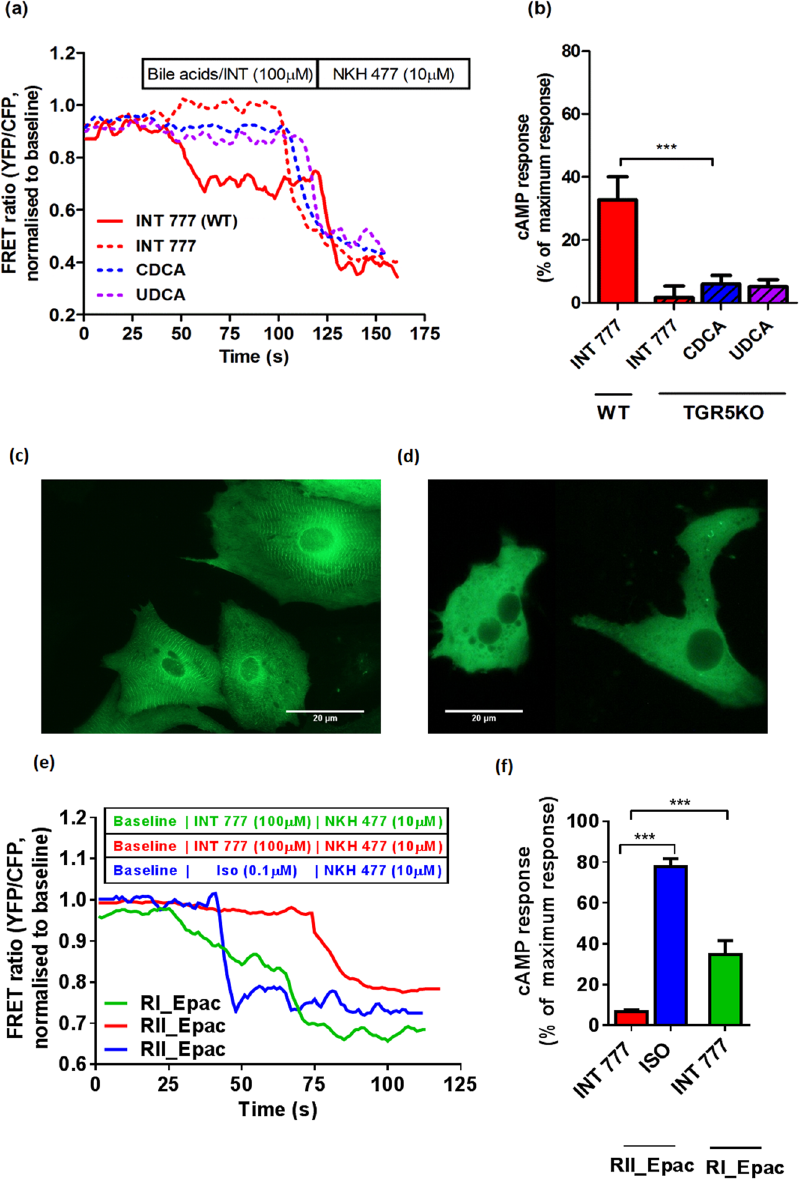
Figure 3. Lack of TGR5 abolishes cAMP response to bile acids in NRVMs. ( a ) Representative FRET traces of TGR5KO neonatal mouse cardiomyocytes treated with CDCA and UDCA at 100 μ M. ( b ) Normalised cAMP responses of TGR5KO neonatal mouse cardiomyocytes following stimulation with CDCA and UDCA at 100 μ M (n = 6). Adenylate cyclase isoform specificity in cAMP production following TGR5 stimulation Representative images of fluorescent neonatal rat cardiomyocytes transfected with RII-Epac FRET sensor ( c ) and RI-Epac sensor ( d ); ( e ) Representative FRET tracing of neonatal rat cardiomyocytes transfected with Ad-RII-Epac sensor following stimulation with 100 μ M INT 777 (red line) and 0.1 μ M Isoprenaline (blue line) and transfected with Ad-RI-Epac sensor following stimulation with 100 μ M INT 777 (green line); ( f ) % of cAMP response in neonatal rat cardiomyocytes treated as in ( e ) (n ≥ 10, *** p < 0.0001, Unpaired t-test). Data presented as mean ±